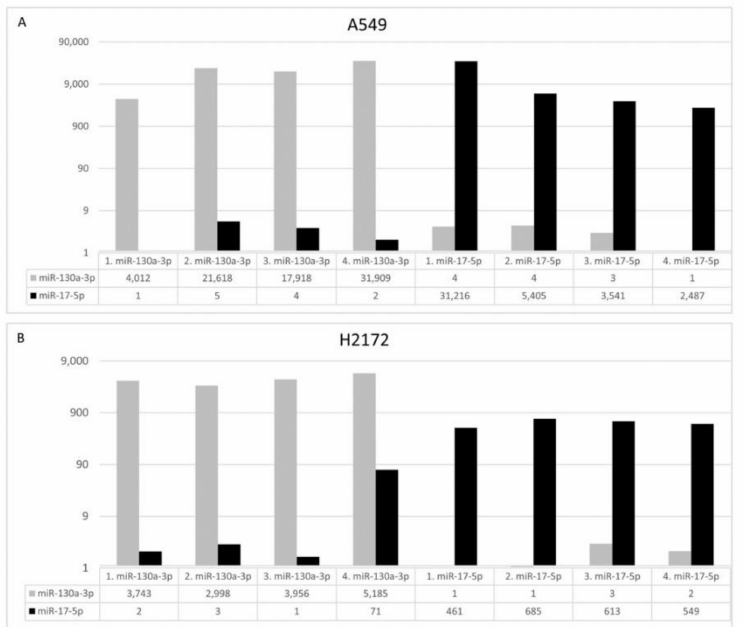
Figure 6. Bar charts report the fold changes of miR-130a-3p (grey) and miR-17-5p (black) at 72 h after their transfections in A549 ( A ) and H2172 ( B ) cells. In each experiment the miR transfected cells were compared to the cells transfected with a negative control. X -axis: reports the transfections with the fold changes; Y -axis: reports the fold values transformed in base 10-log scale.